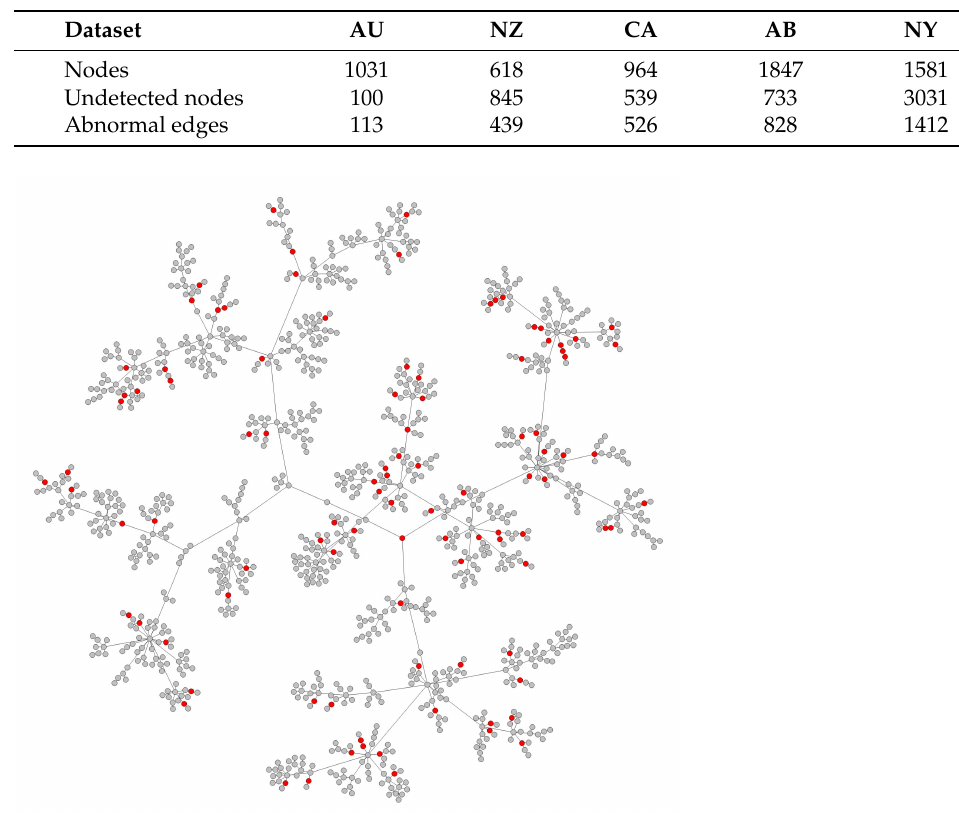
Table 1. The number of sampled nodes, inferred undetected nodes, and inferred abnormal edges in real datasets. Australia is represented as AU, New Zealand is represented as NZ, Canada is represented as CA, Alberta is represented as AB, New York State is represented as NY.